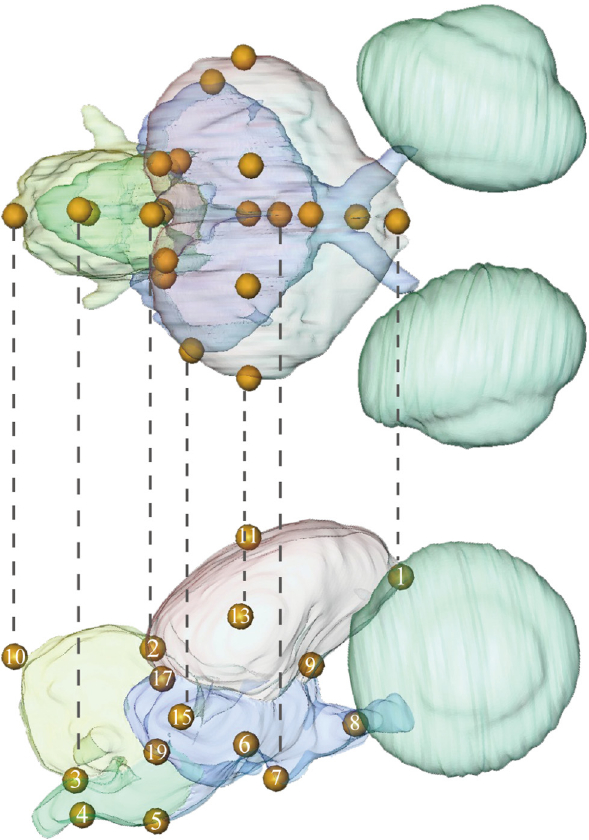
Fig 2. The three-dimensional brain landmarks used for shape analysis shown in dorsal (upper) and right lateral (lower) views.